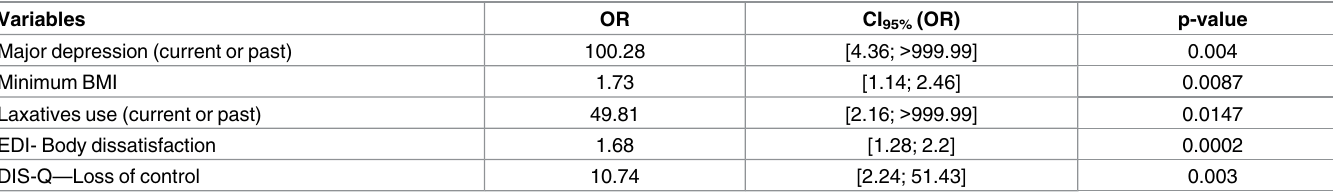
Table 4. Multiple logistic regression analysis (final model): factors associated with “marked concerns with body shape” (N =